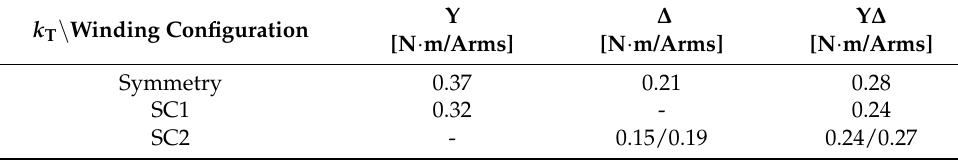
Table 2. Torque constant k T